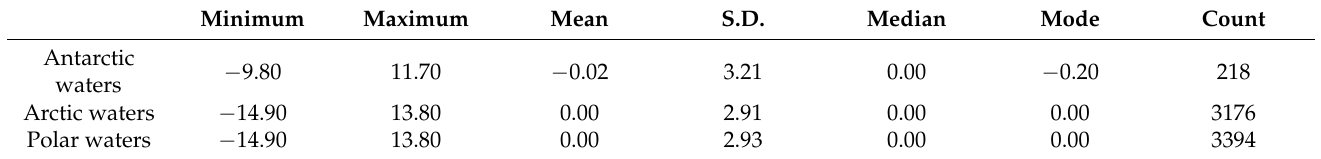
Figure 4. Box plot of ship speed variation in polar waters. Table 2. Statistics of ship speed variation in polar waters.